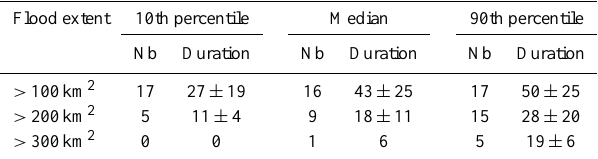
Table 8. Number of floods and their mean duration (days) for 2002–2011.